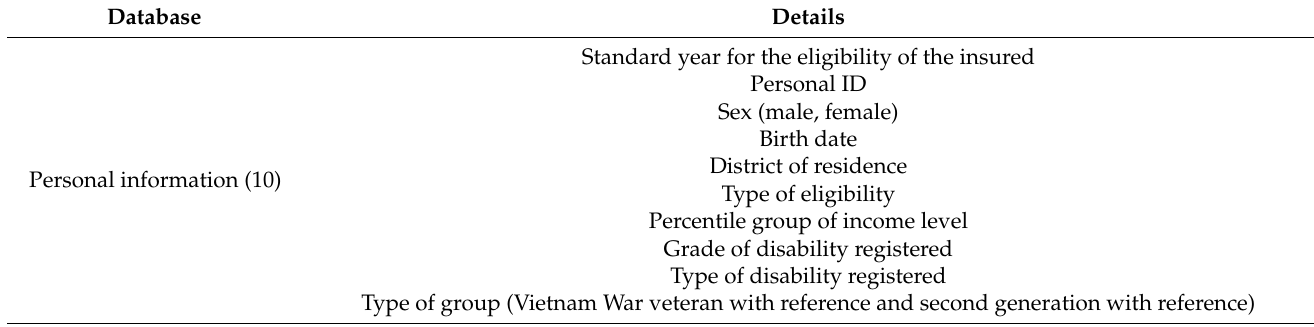
Table 4. List of variables in the KOVECO